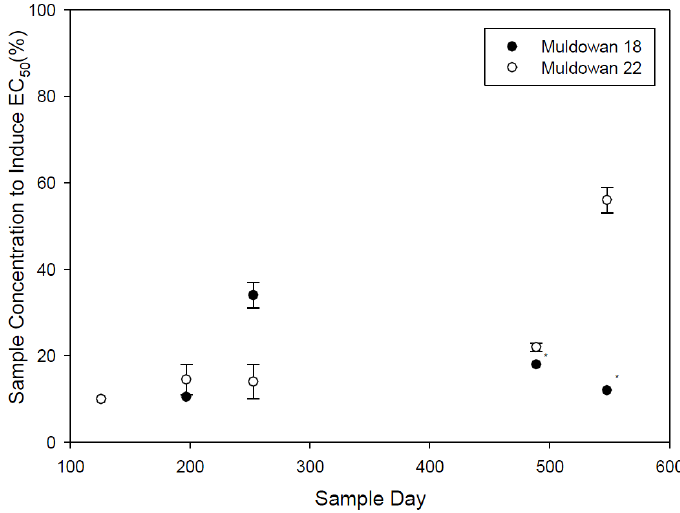
Figure 3. Microtox EC 50 for operational samples, error bars are standard error ( n = 2), last two sample periods for Muldowan 18 only consisted of 1 sample.